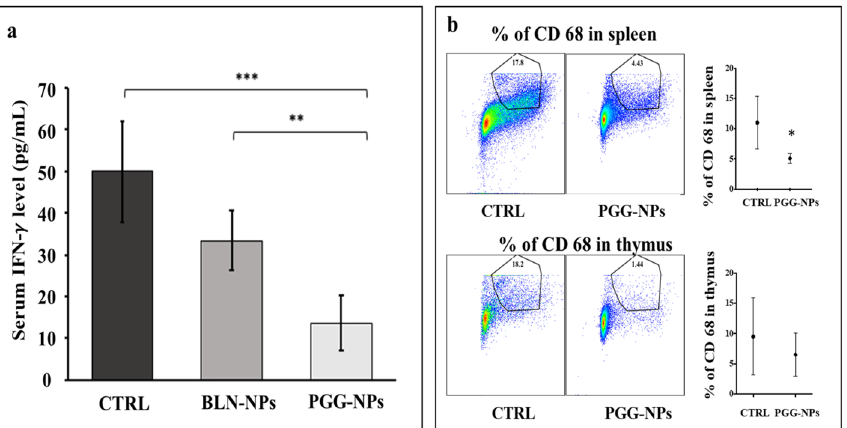
Figure 7. Systemic inflammatory response analysis. ( a ) Serum IFN-γ concentrations of control, BLN-NPs and PGG-NPs groups. PGG-NPs-treated group showed significantly lower serum IFN- γ level than both control and BLN-NPs groups; ( b ) Flow cytometry dot plots and scatter plot for CD 68 positive cells in spleen and thymus from control and PGG-NPs-treated group. The percentage of CD 68 positive cells significantly decreased